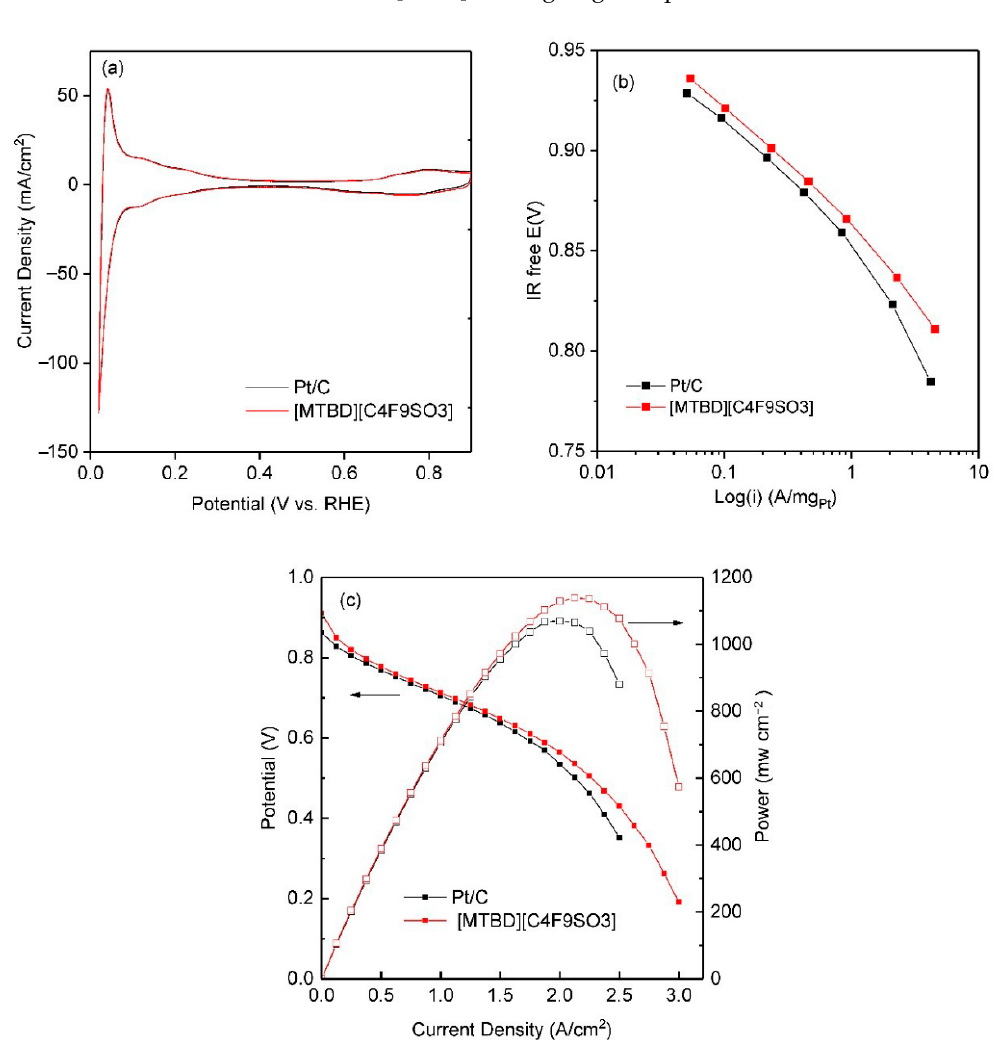
Figure 10. Electrochemical characterizations of Pt/C (TKK) and Pt/C(TKK)-[MTBD][C 4 F 9 SO 3 ] (IL/C = 0.2) in MEA. ( a ) cyclic voltammograms measured at 100% RH under H 2 /N 2 . ( b ) ORR polarization curves collected at 100% RH in H 2 /O 2 at 100% RH under 100 kPa(abs.) ( c ) Polarization curves obtained in H 2 /Air at 70 °C and 100 RH under gauge pressure of 150 kPa.